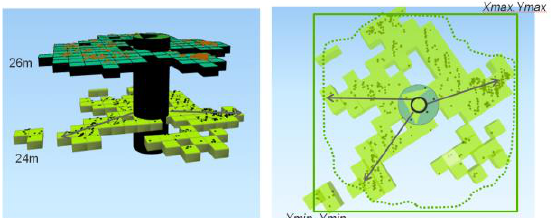
Figure 2. Profiling branches at a given height h along the stem